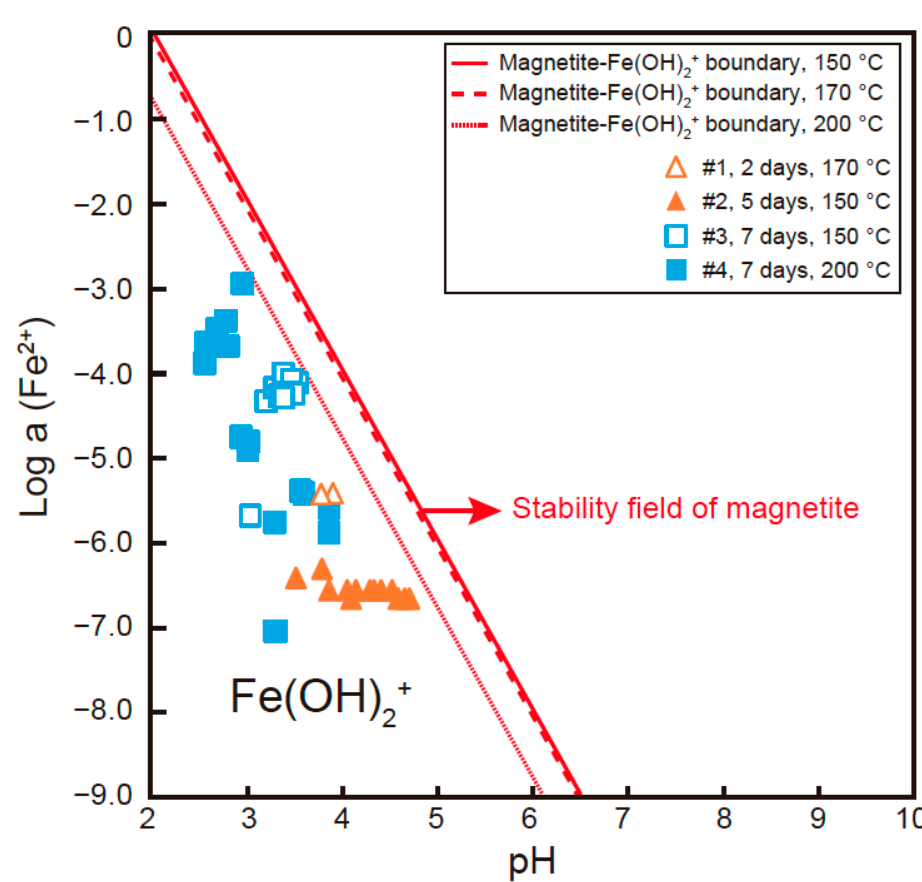
Figure 7. pH-log activity stability fields of possible Fe phases at 150, 170, and 200 °C. Calculated solution compositions of the samples from runs 1–4 at 150, 170, and 200 °C are plotted in the phase diagram.